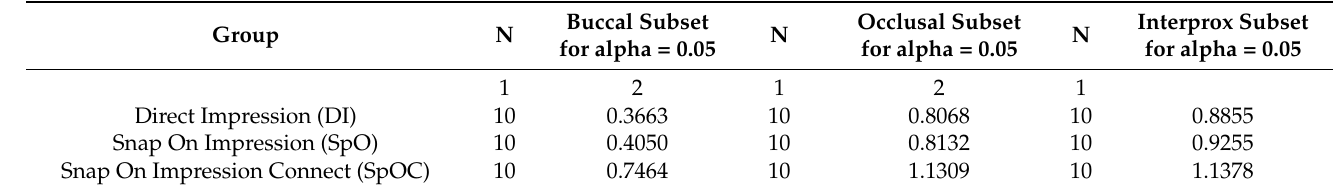
Table 2. Post-hoc Tukey’s test comparing the three surfaces of each study group and the master